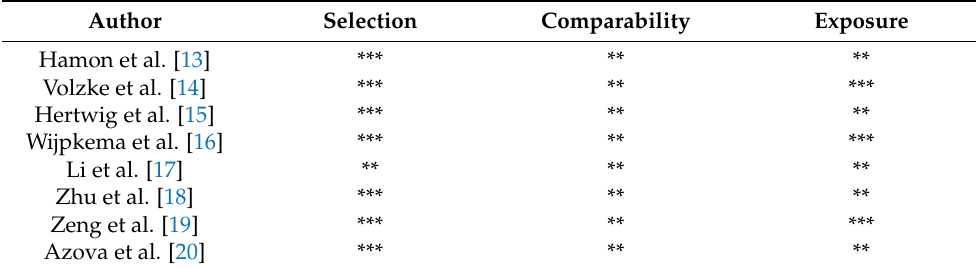
Table 2. The results of Newcastle-Ottawa Scale.